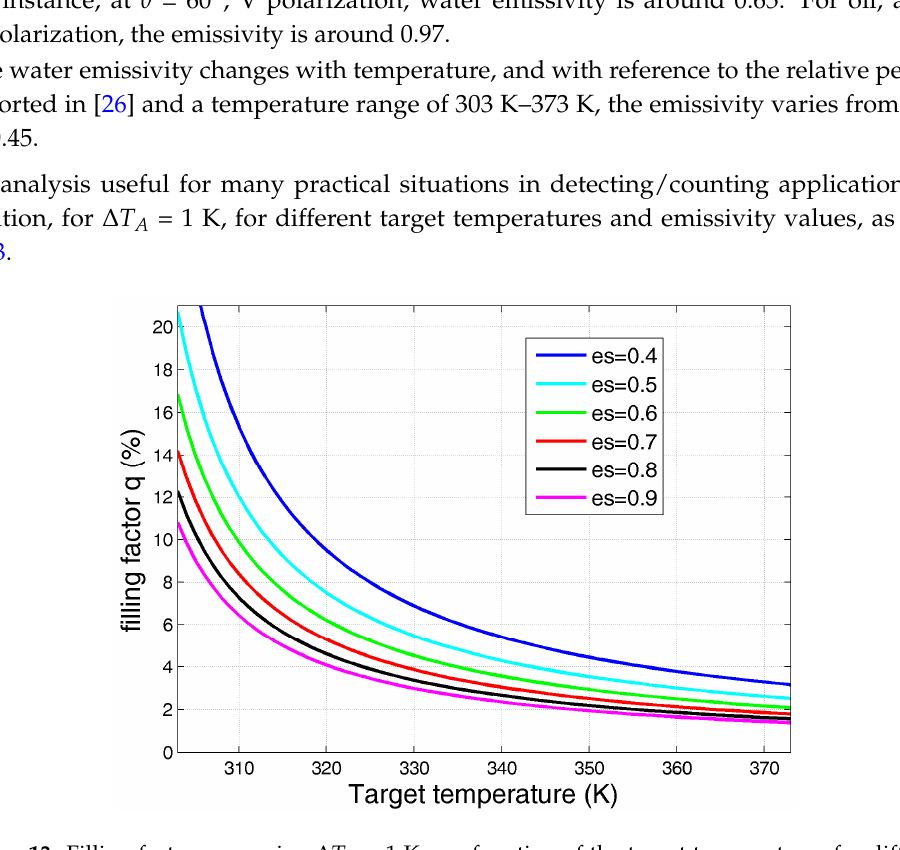
Figure 13. Filling factor q ensuring ∆ T A = 1 K as a function of the target temperatures for different emissivity values ( T env = 292.1; T bkg = 292.8; e bkg = 0.99).